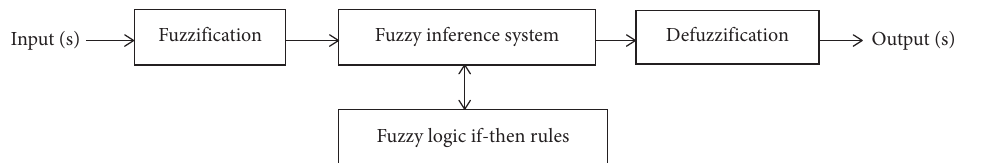
Figure 4: Structure of a fuzzy inference